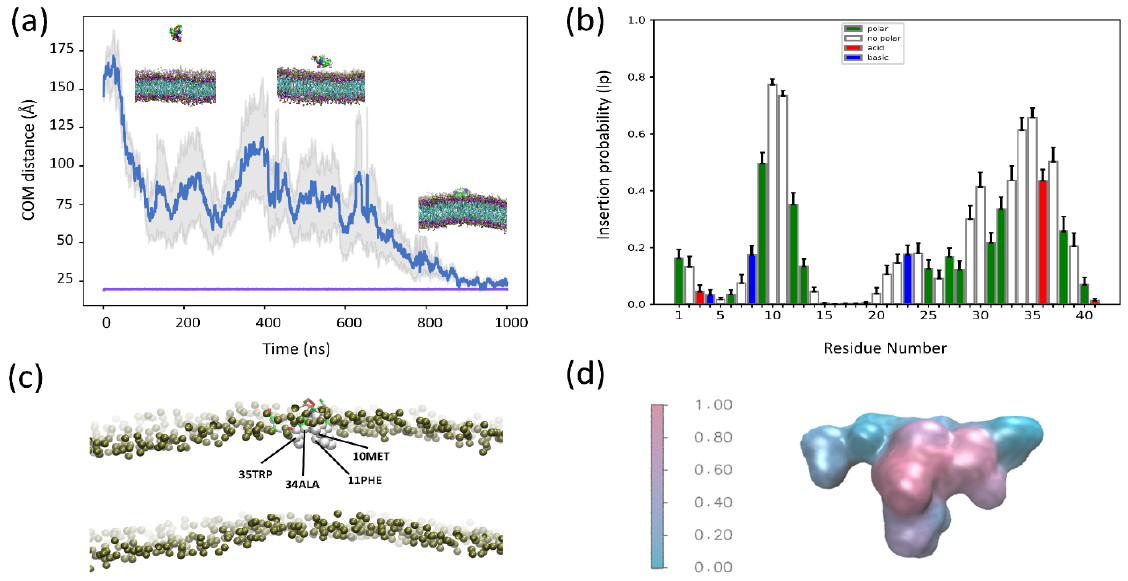
Figure 3. Coarse-grained MD simulations of SNX-482 and POPC: POPG (1:1) ( a ) Average distance as a function of time between the center of mass (COM) of SNX-482 and the (COM) of the membrane bilayer for four independent simulations. The gray colored region corresponds to the mean error of the distances. The purple line represents the position of the membrane outer leaflet. ( b ) Average insertion probabilities (Ip) for each residue. ( c ) Snapshot of membrane embedded toxin labelling residues with high ip ( d ) Surface representation of SNX-482 colored by Ip.